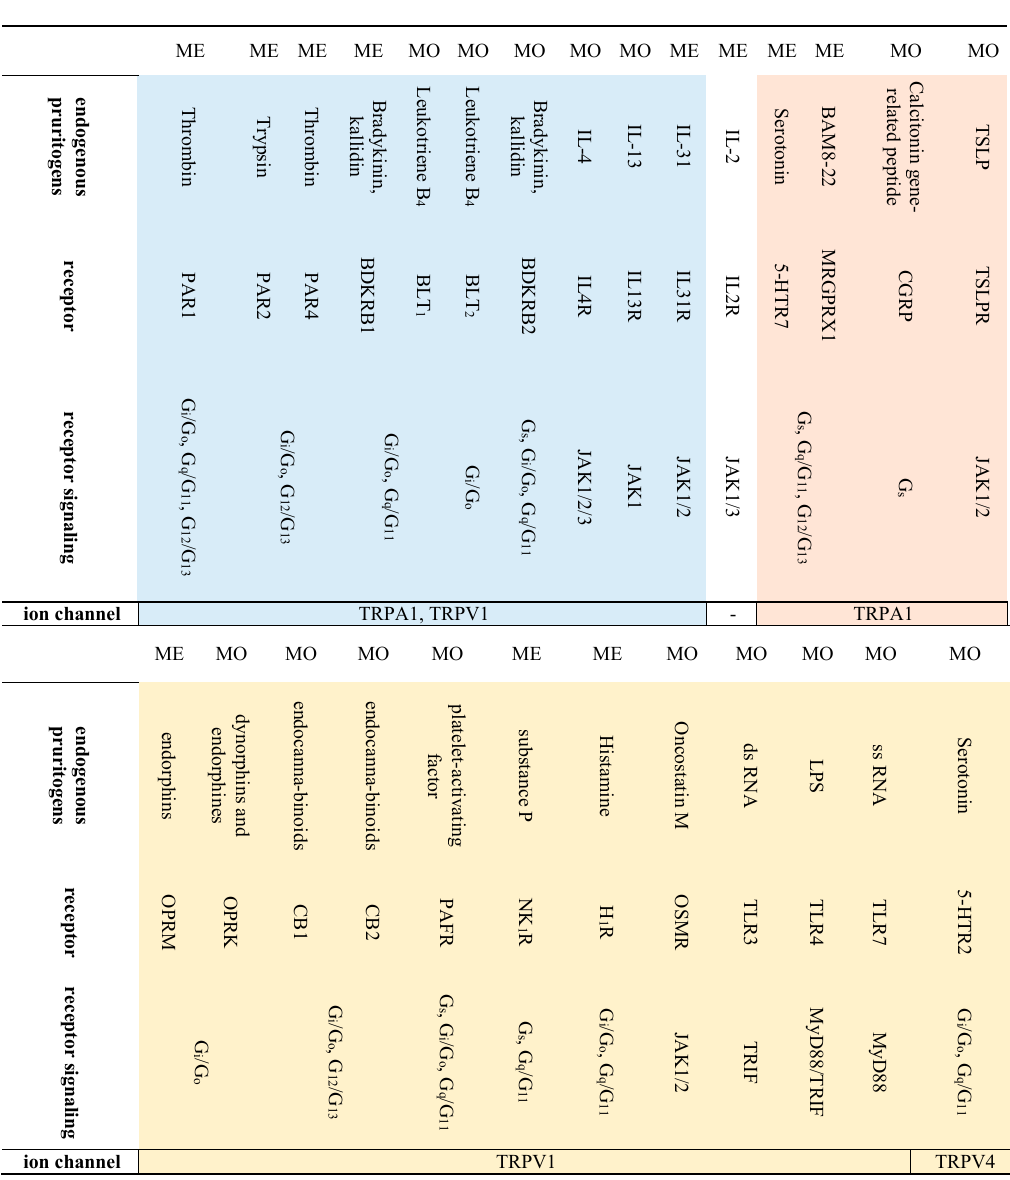
Table 1. Endogenous pruritogens and their signaling pathway. The receptors are grouped by ion channel signaling, G- protein signaling, and kinase signaling. In addition, each receptor and its endogenous pruritogen is categorized as mediator (ME) or modulator (MO). Color coded according to Figure 3.